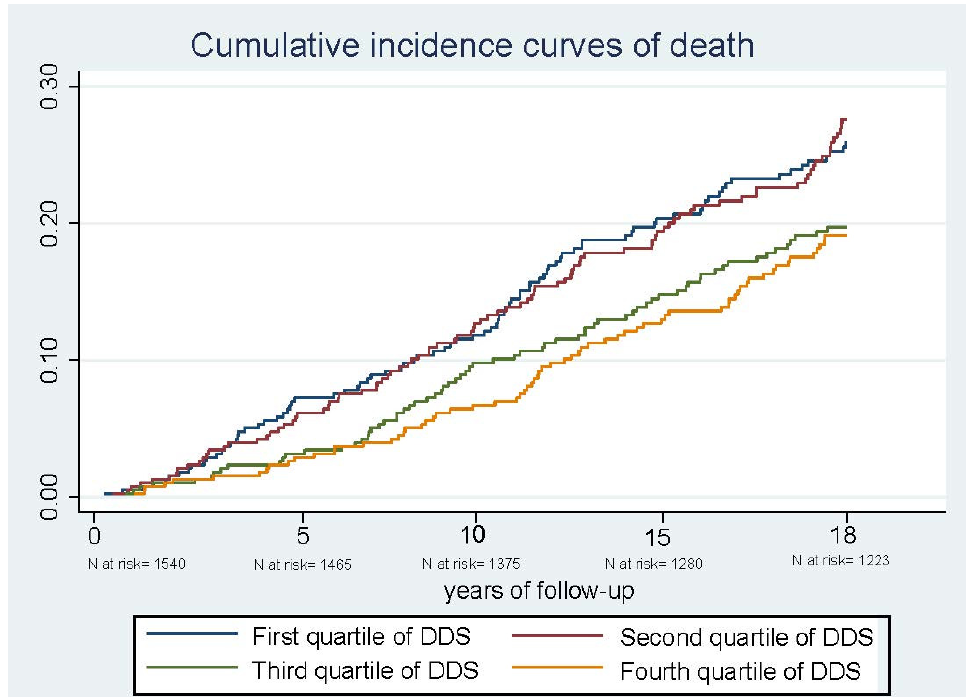
Figure 1. Cumulative incidence curves of death after 18 years of follow-up, according to Dietary Diversity Score (DDS) for all-cause mortality in participants from the Valencia Nutritional Survey in Spain. Table 4. Associations between food groups of the dietary diversity score and all-cause, cardiovascular disease and cancer mortality among participants of the Valencia Nutrition Study in Spain ( n = 1540). Food Components of the DDS p -Value